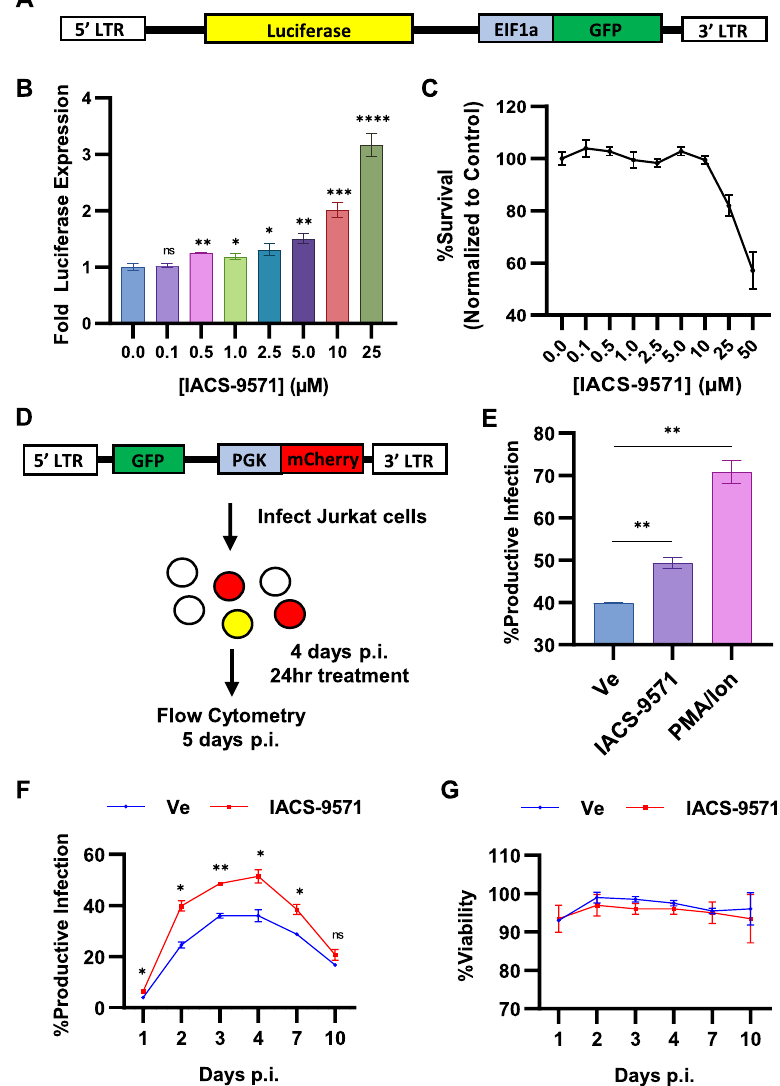
Figure 1. IACS-9571 promotes HIV-1 expression. ( A ) Schematic representation of HIV-1 mini-virus in the Jurkat Tat mHIV-Luciferase cell line, where luciferase is expressed from the 5’ LTR as a fusion with Gag. ( B ) mHIV-Luciferase cells were treated with the indicated concentration of IACS-9571 for 4 h prior to luciferase assay. Results are an average of three determinations, and error bars represent standard deviation. ( C ) mHIV- Luciferase cell viability was determined after 4 h treatment with IACS-9571 at the indicated concentration. Viability assays were performed in duplicate with error bars representing standard deviation. ( D ) Depiction of Red-Green-HIV-1 (RGH) reactivation assays. RGH is a full-length replication incompetent HIV-1 virus with GFP expressed by the 5’ LTR as a fusion with Gag and Nef is replaced with a PGK promoter expressing mCherry 11 . Wildtype Jurkat T cells were infected with RGH at a low MOI; 4 days post-infection (p.i.), pools of cells were treated with 10 µM IACS-9571, 20 nM PMA/1 µM ionomycin, or left untreated for 24 h. Subsequently, productive and latently infected cells were measured by expression of GFP using flow cytometry. ( E ) Ratio of productively infected cells following RGH reactivation. Results are an average of two determinations, and error bars represent standard deviation. ( F ) Wildtype Jurkat T cells infected with RGH were treated with or without 10 µM IACS-9571 throughout the course of infection. Flow cytometry was performed on the indicated day post- infection (p.i.). Shown are the results of duplicate experiments, and error bars represent standard deviation. ( G ) Cell viability was determined at each time post-infection. Results of two measurements are shown, with error bars representing standard